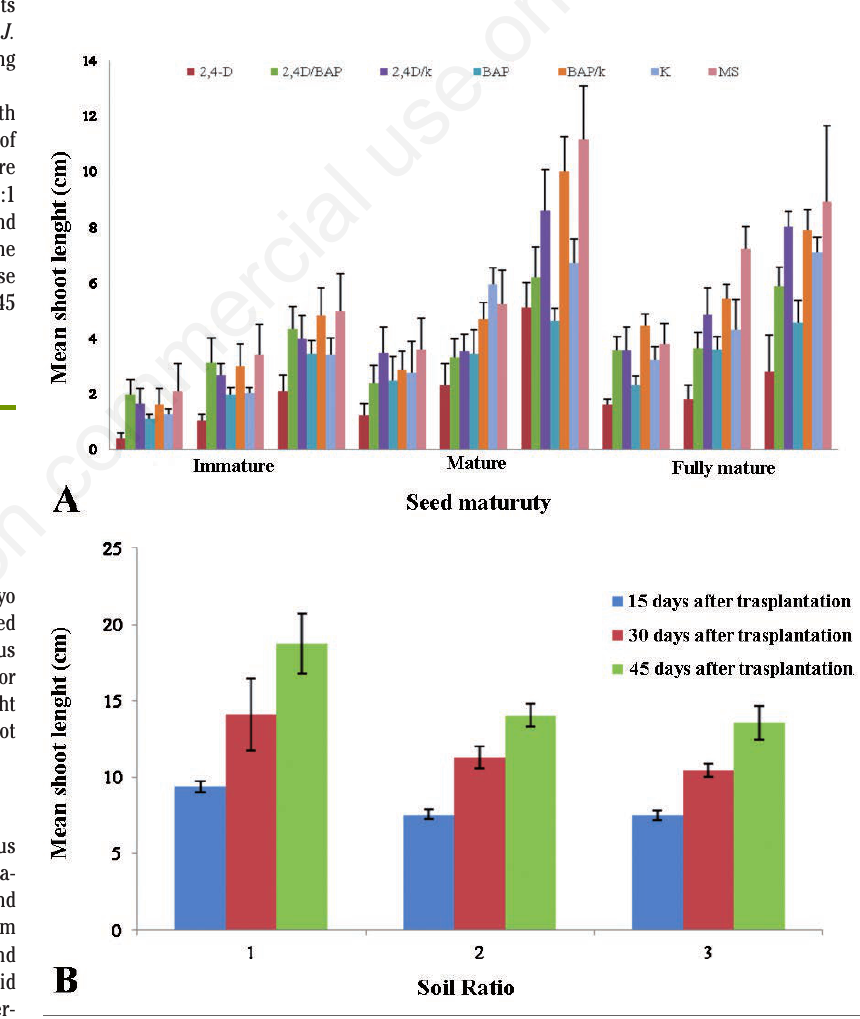
Figure 2. A) Effect of different plant growth regulators combinations (with fixed concen- tration of 1.0 mg/L) on shoot length of the different seed maturity (n=20). B) Mean shoot length on the three sand and soil mixture ratios. Mean ± standard deviation; One way Anova with LSD at 5%,